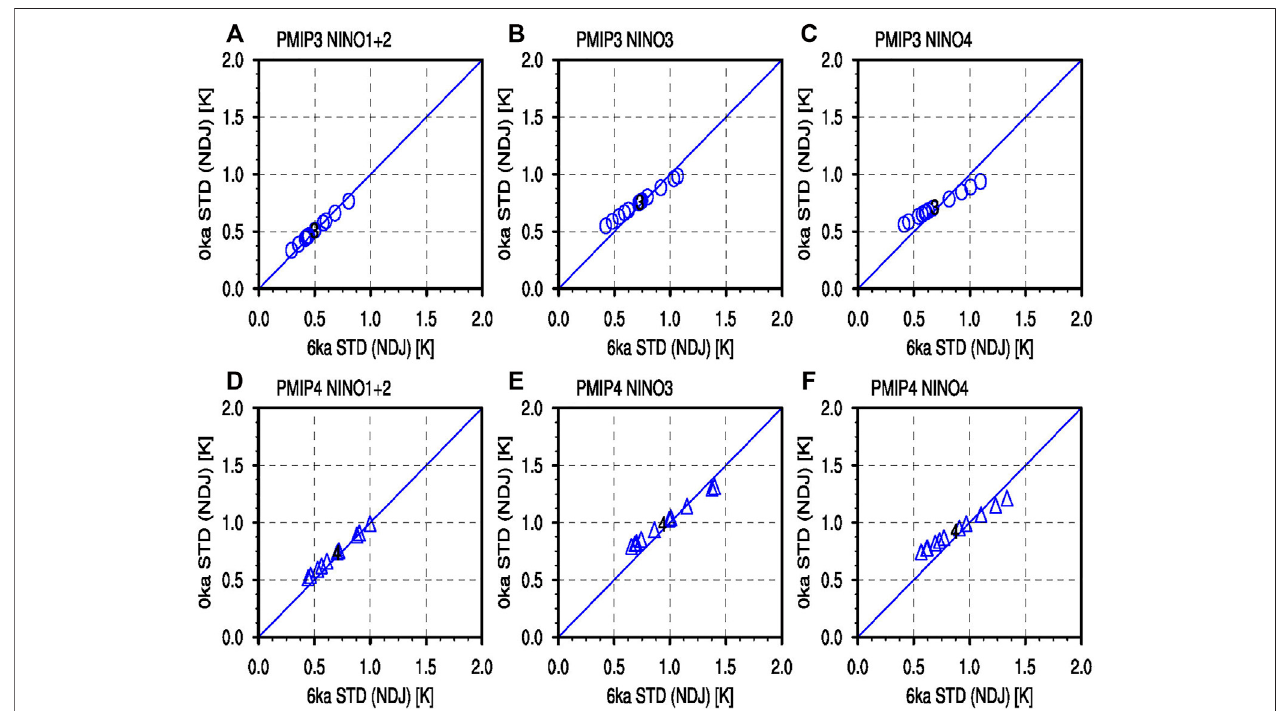
FIGURE 9 | Scatter plots for the STD of the ENSO indices in boreal winter (November – January) derived from PMIP3 and PMIP4 models. The MMEs of PMIP3 and PMIP4 models are marked by 3 and 4, respectively. (A) and (D) for Niño1+2 (90 ° – 80 ° W, 0 ° – 10 ° S) indices, (B) and (E) for Niño3 (150 ° – 90 ° W, 5 ° S – 5 ° N) indices, and (C)